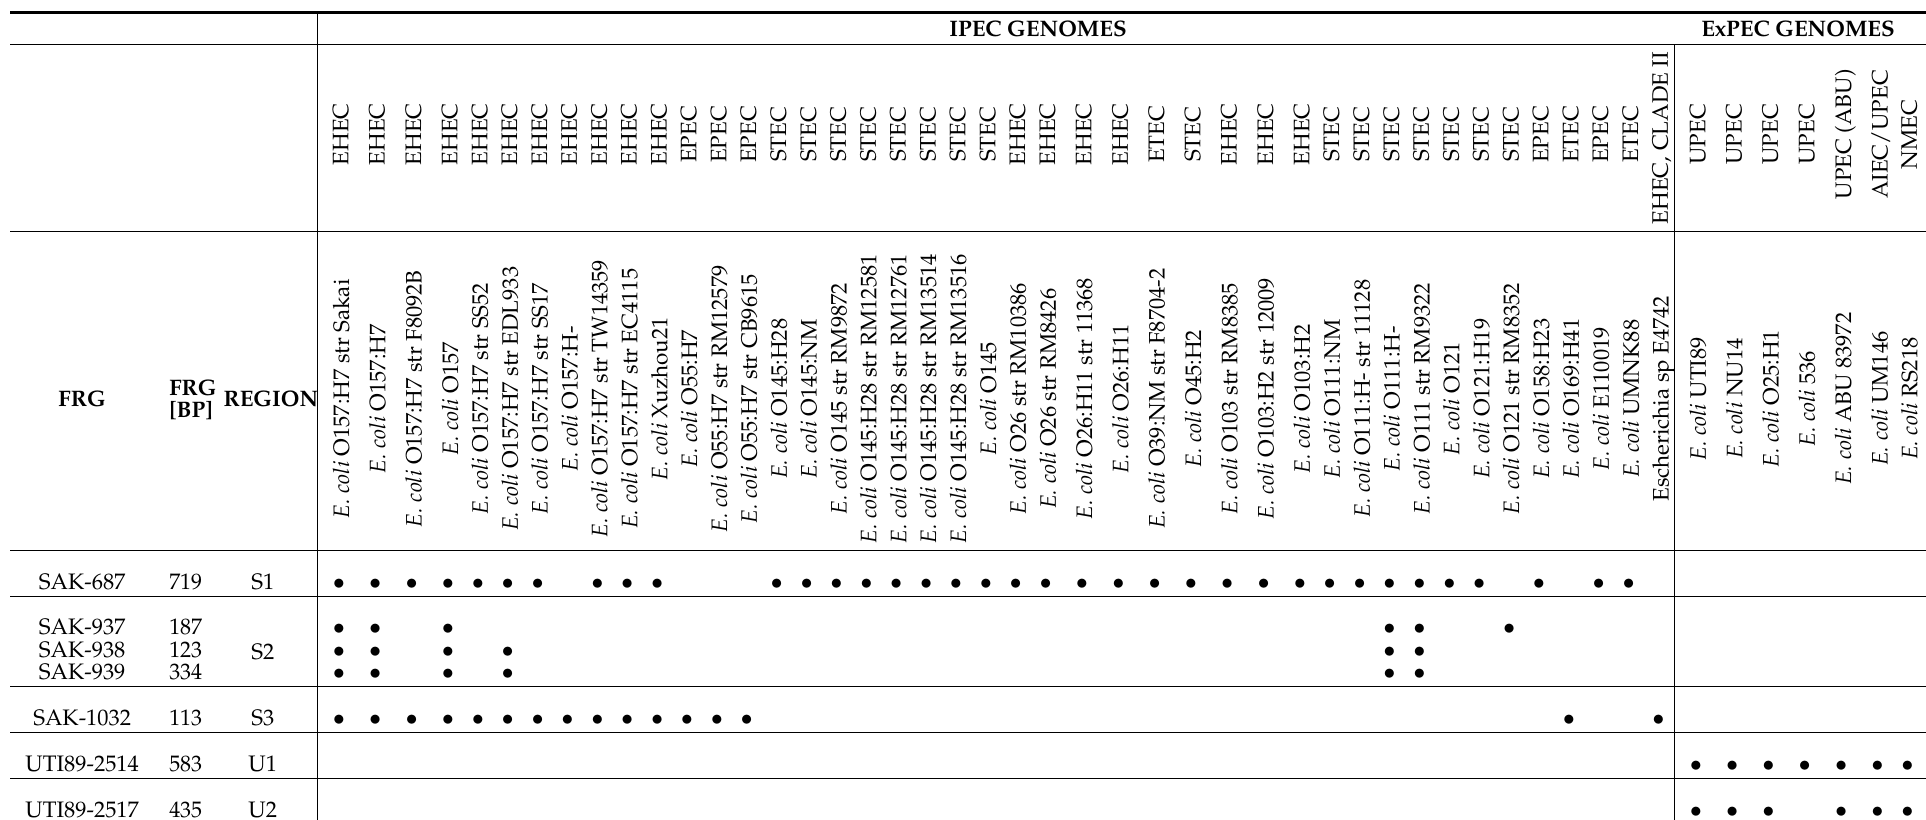
Table 3. The list of genomic fragments of E. coli UTI89 identified exclusively in the ExPEC E. coli genomes, and genomic fragments of E. coli O157:H7 Sakai identified exclusively in the IPEC E. coli genomes (black dots). IPEC GENOMES ExPEC